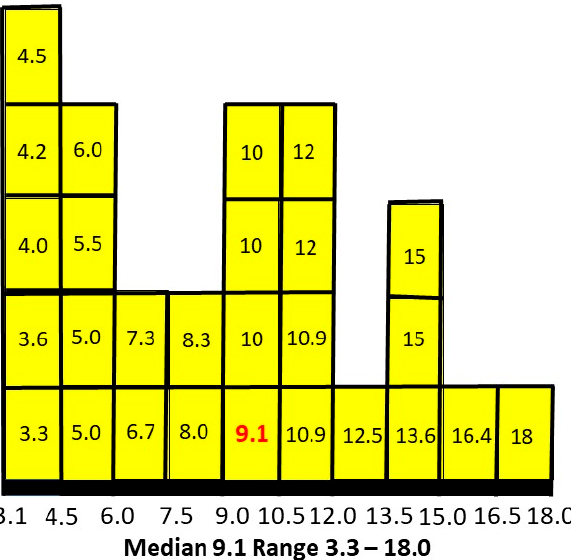
Figure 6. P(AN|ASD) distributed as percentages.